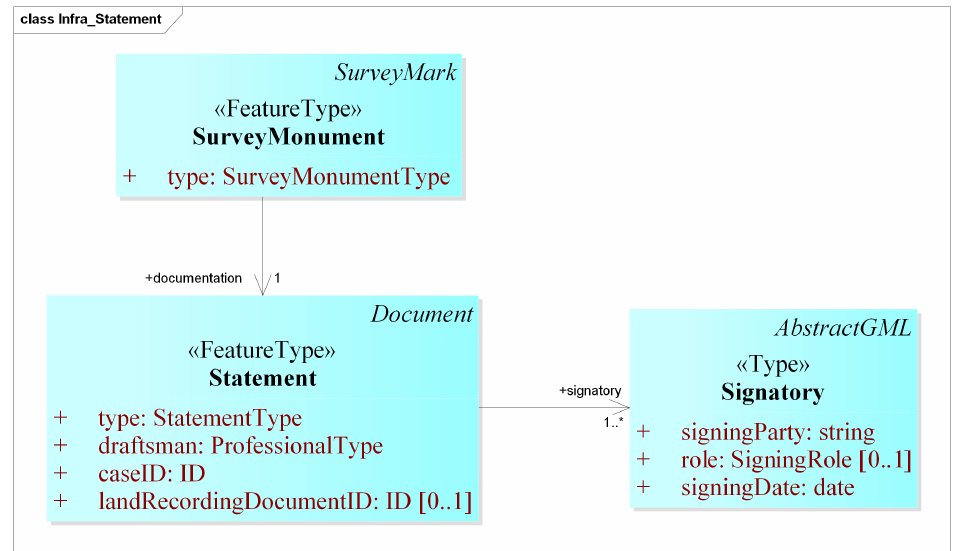
Figure A3. The UML excerpt depicts the LandInfra classes SurveyMonument and Statement in the CityGML Infra ADE.